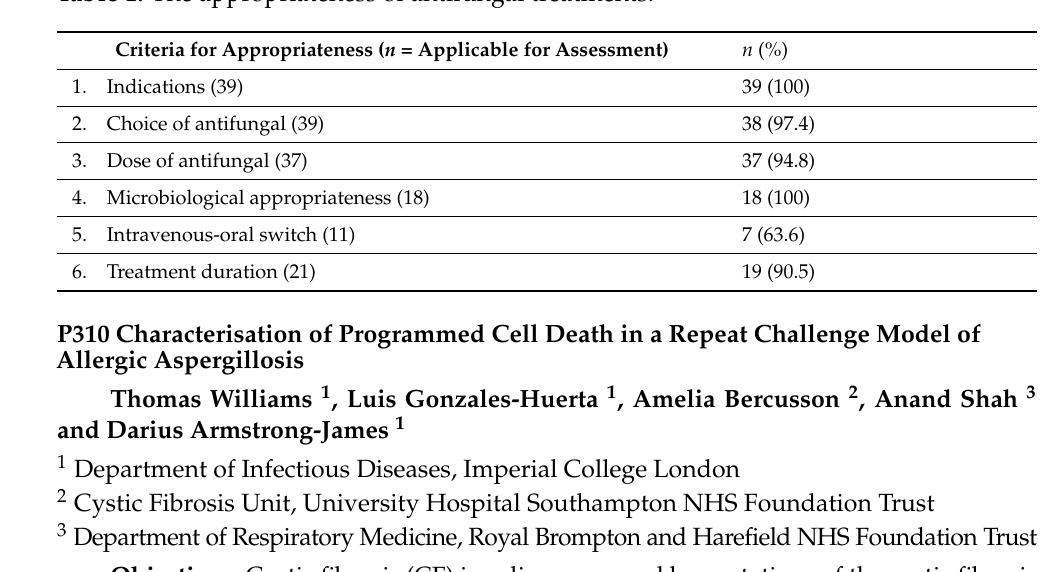
Table 1. The appropriateness of antifungal